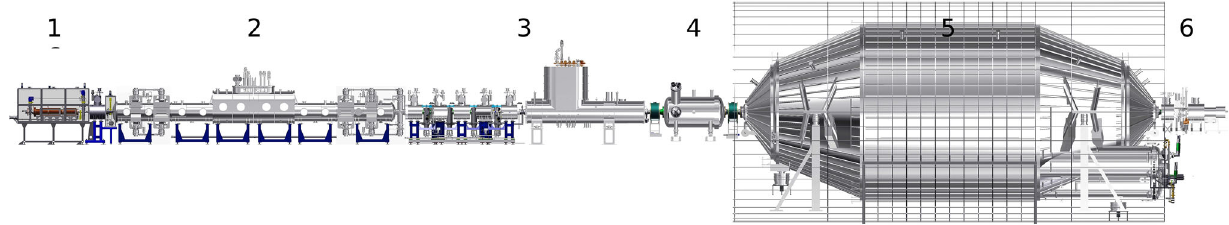
Fig. 1 Experimental setup of the KATRIN experiment. The main components are: (1) calibration and monitoring rear section, (2) windowless gaseous tritium source, (3) transport section, (4) pre-spectrometer, (5) main spectrometer, and (6) focal plane detector